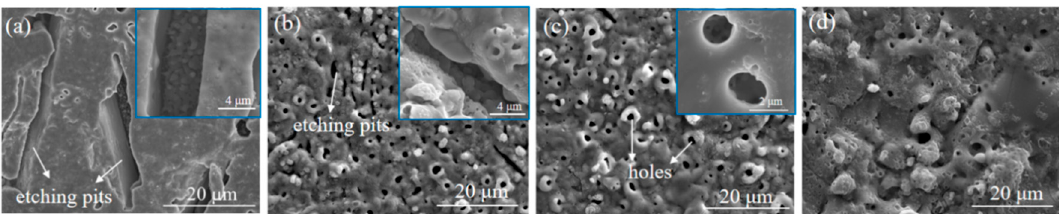
Figure 13. The morphology of etching pits at different MAO treatment time: ( a ) 2 min; ( b ) 5 min; ( c ) 10 min; ( d ) 20 min.